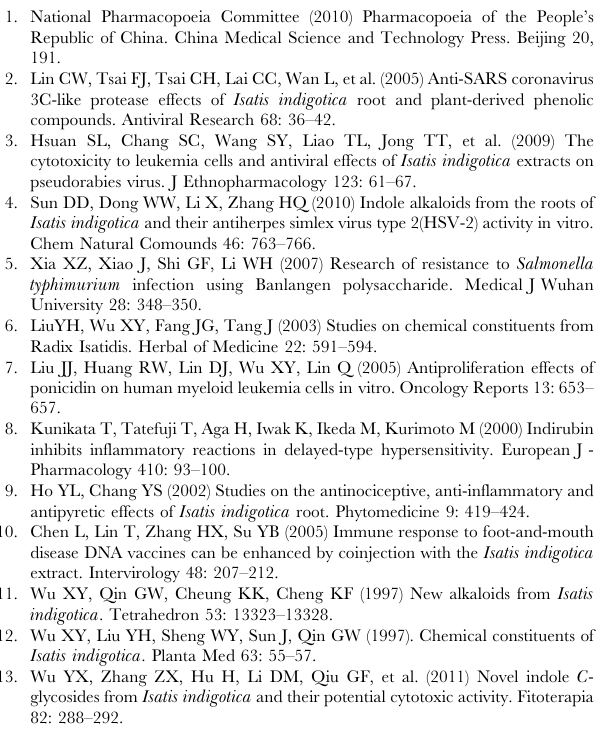
Table S1 Information of the seven selected unigenes. Table S2 List of unigenes with a potential role in biosynthesis of indole and its derivatives. Table S3 Annotation and classification of 28184 I. indigotica unigenes. Table S4 Statistics of the SSRs identified in the I. indigotica